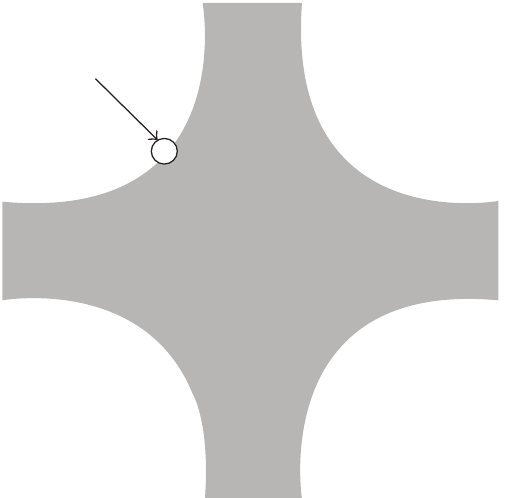
Figure 4: Position of the probe monitoring the axial evolution of the wall temperature.